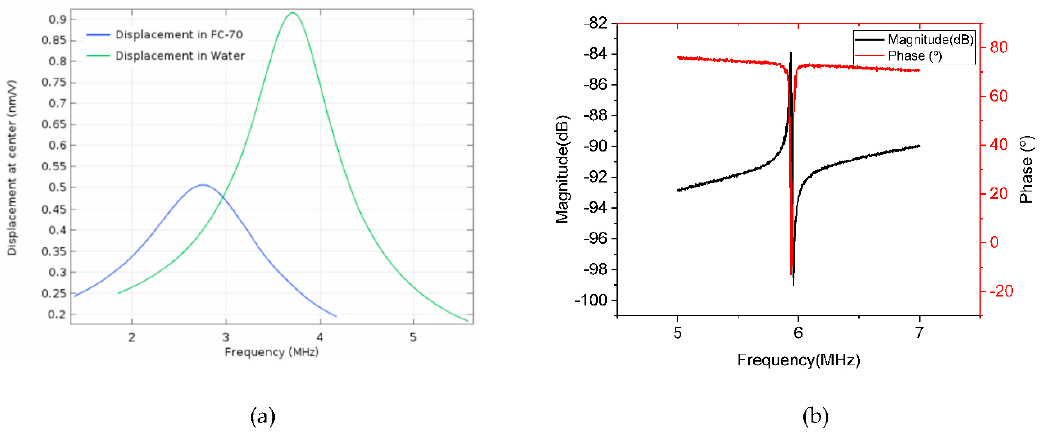
Figure 2. Frequency responses for the PMUT: ( a ) COMSOL simulation of PMUT displacement in different media; ( b ) Electrical PMUT characterization in air, using inner top electrode as input and outer top electrode as